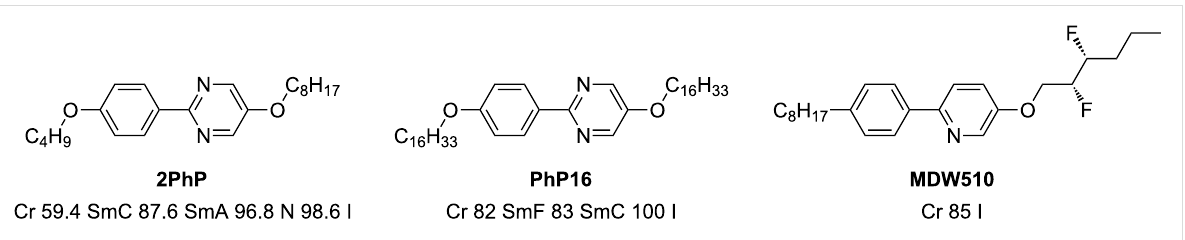
Scheme 1: Chemical structures and phase-transition temperatures of the mesogens 2PhP and PhP16 and of the chiral dopant MDW510 .